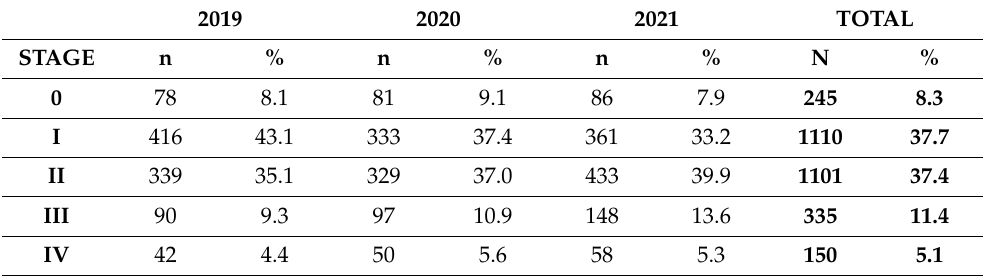
Table 3. BC cases with clinical staging, and percentage distribution of each BC stage in years 2019–2021.